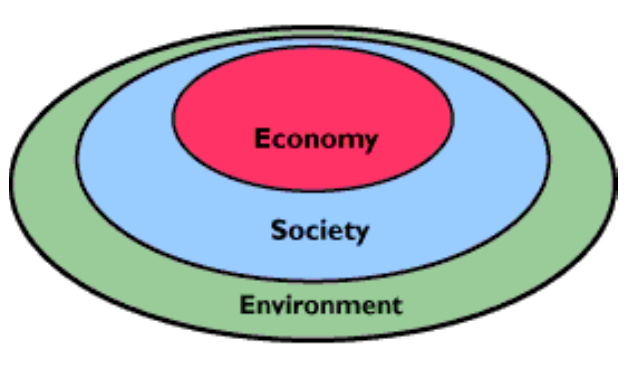
Fig. 1 . Sustainable Community Model in which the economy depends on society, which depends on the environment. (© 2010 Maureen Hart. Source: www.